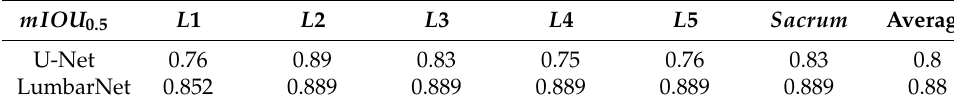
Figure 10. Training history of LumbarNet. Table 2. mIOU Comparison of U-Net and LumbarNet.